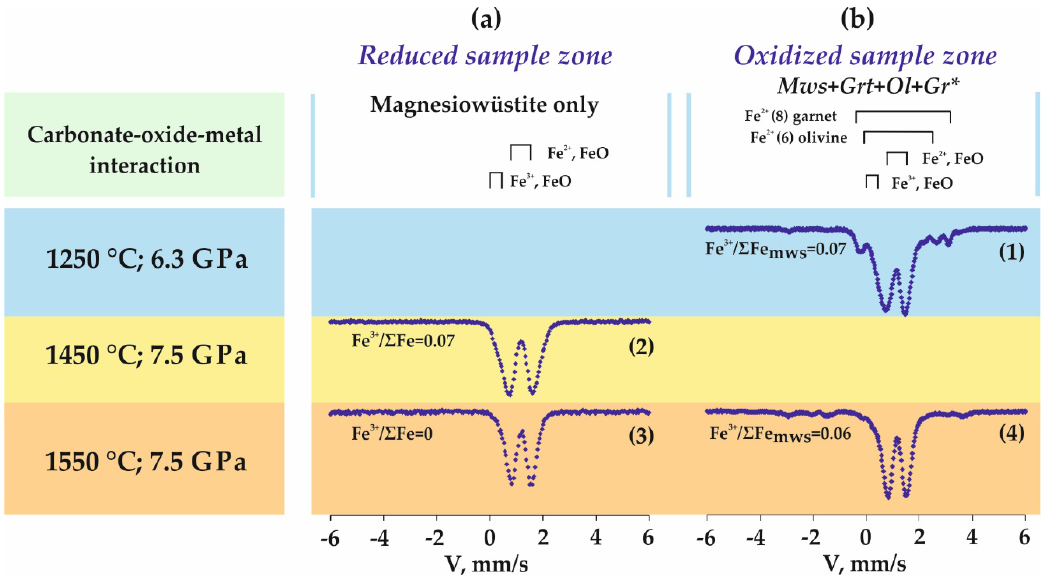
Figure 8. Mössbauer spectra of samples from reduced (2,4) and oxidized (1,3) zones, which were produced in experiments in the carbonate-oxide-metal system. ( a ) assemblages of reduced sample zone, ( b ) assemblages of oxidized sample zone.